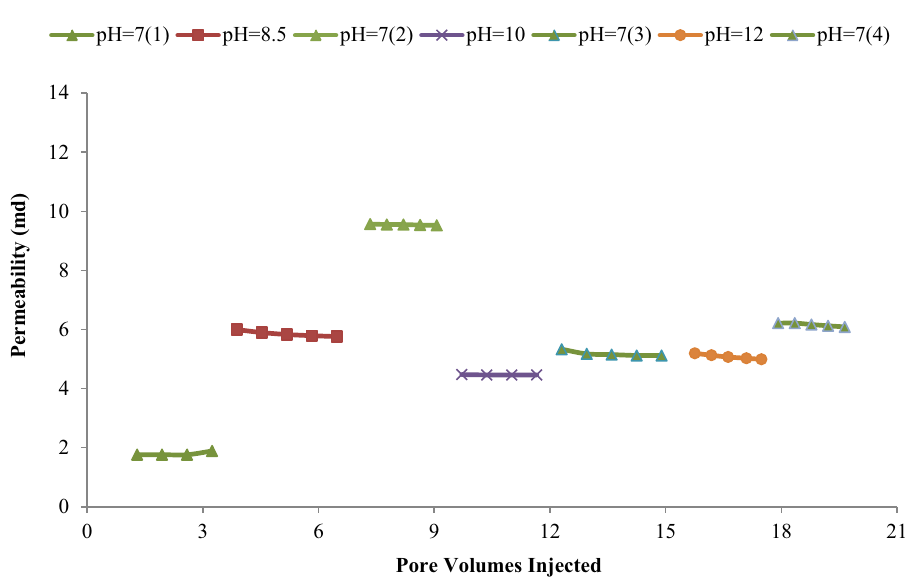
Fig. 6 The permeability altera- tion during injection of different alkaline fluids in core no.2